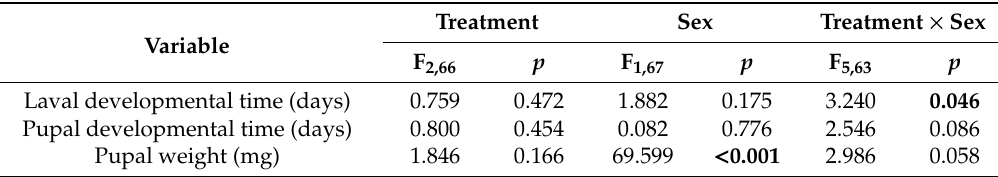
Table 1. Results of two-way ANCOVAs analyses on the e ff ects of aboveground Phthorimaea operculella feeding on the larval and pupal developmental times and pupal weight of conspecific larvae of di ff erent sex in potato tuber tissues.